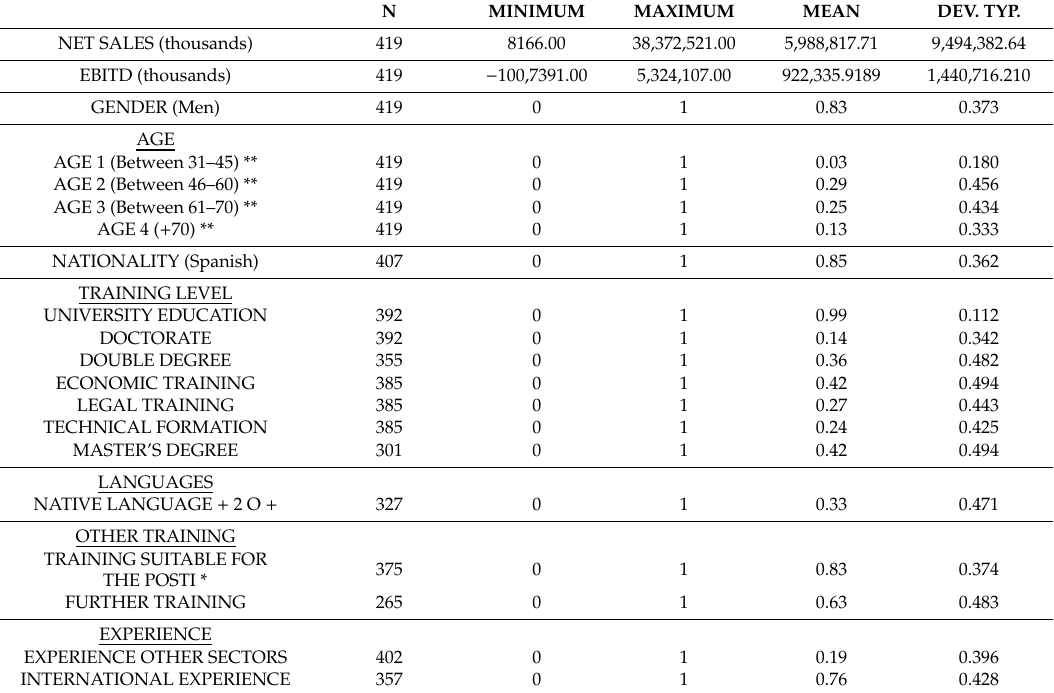
Table 1. Variable descriptive statistics included in the regression.